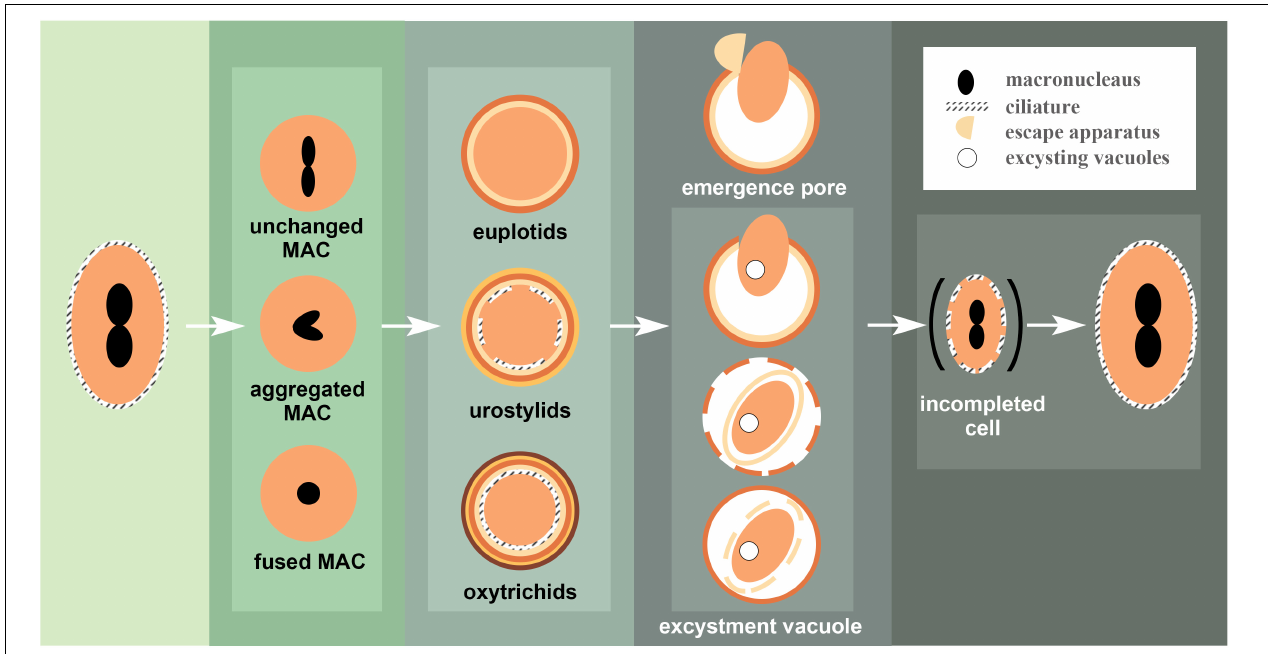
FIGURE 5 | Exemplar patterns of encystment and excystment observed in ciliates. When vegetative cells encyst, the changes in macronuclear morphology are represented by three cases. Mature cysts are similarly divided into three categories based on the degree of kinetosomes resorption, which corresponds to the number of cyst wall layers. During excystment, the (in) completed vegetative cell escapes the cyst wall through an escape apparatus or under the pressure of an excystation